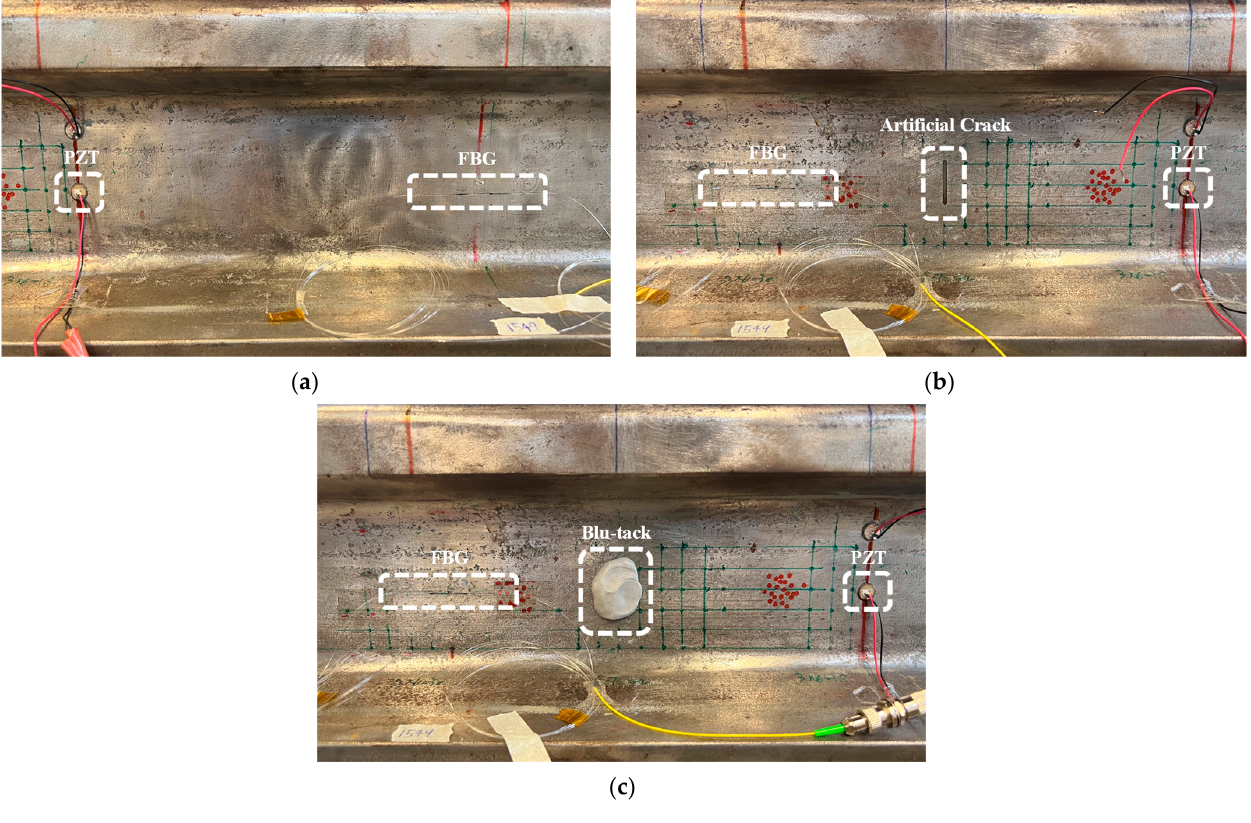
Figure 6. The sensors arrangement for ( a ) the intact condition; ( b ) the damaged condition with an artificial crack; ( c ) the damaged condition covered with blu-tack